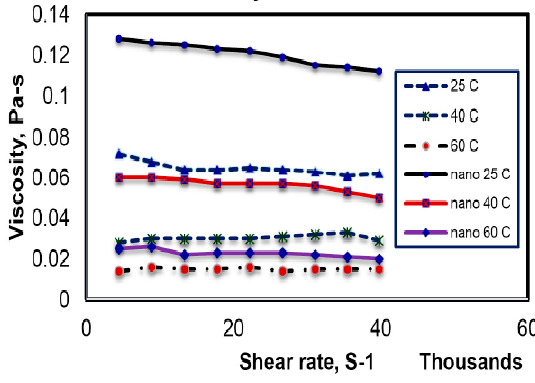
Figure 7. Influence parameters of viscosities of SiO 2 nanofluids [28].